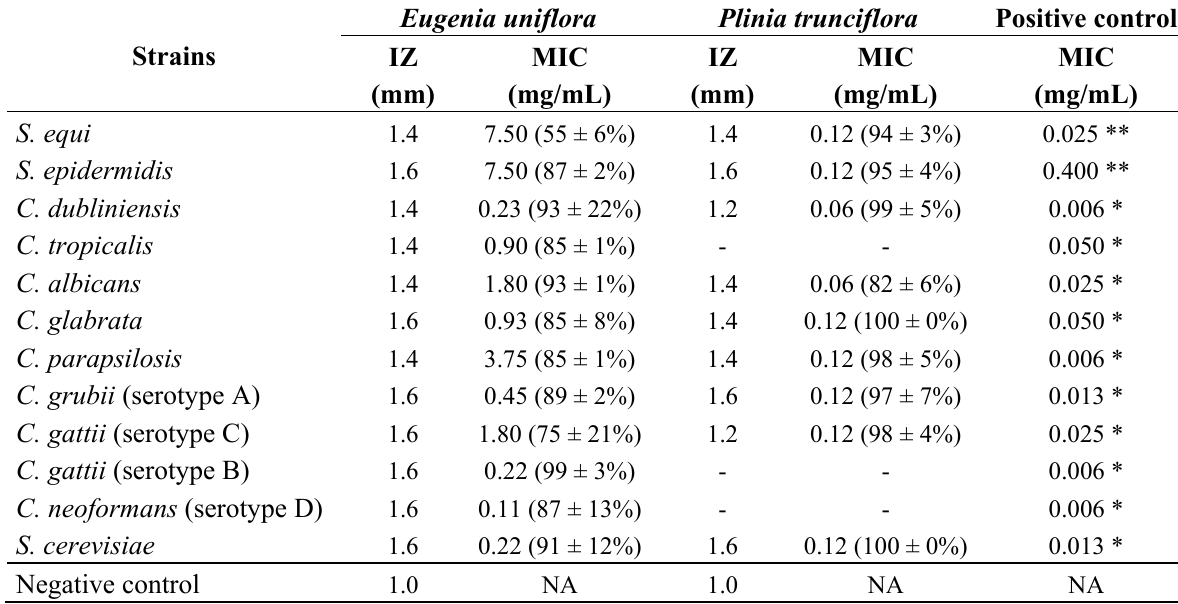
Table 2. Antimicrobial activity of two essential oils (from E. uniflora and P. trunciflora ) evaluated by the disk diffusion method (IZ) and minimal inhibitory concentration